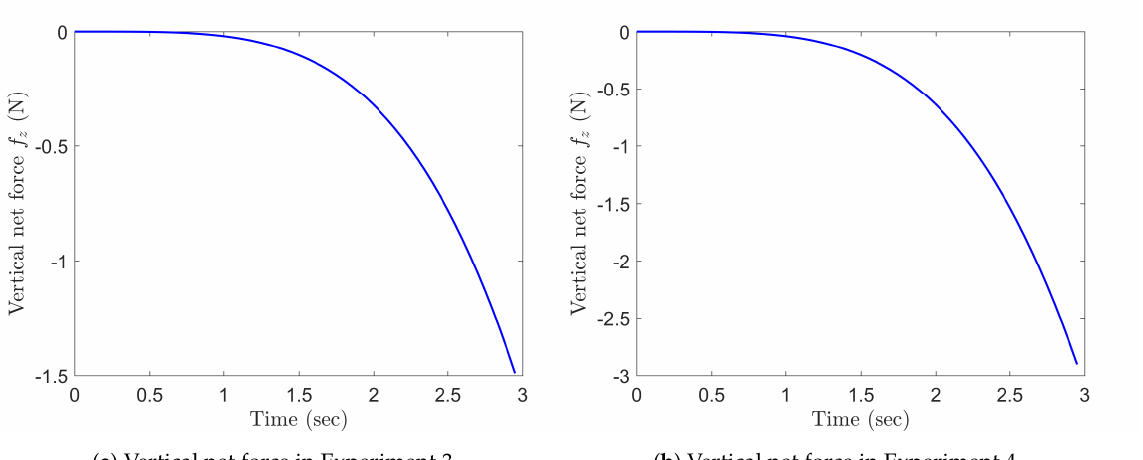
Figure 10. Comparison of the values of the vertical net force predicted by the model through the relation